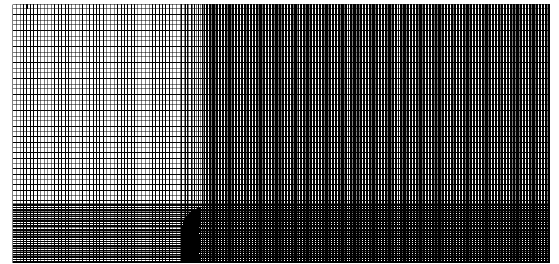
Figure 3. Result of meshing in computational domain.